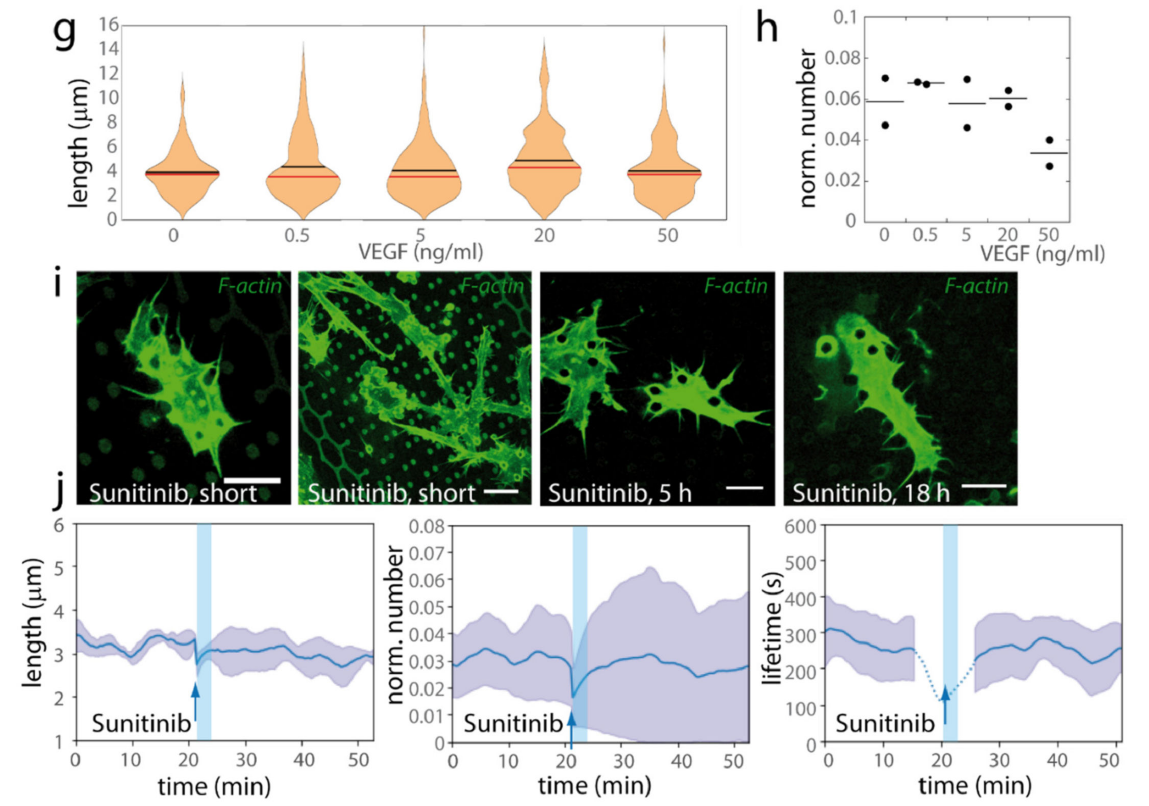
Figure 9. Dependence on VEGF. ( a – h ) HUVECs were cultivated on l7L14-open microstructures, and long- term cultures were performed in different VEGF concentrations. Cell organization was studied from fixed samples. ( a , b ) Culture without VEGF: ( a ) ECGM media (Promocell), which contains no VEGF supplement, ( b ) ECGM2 media without the VEGF supplement. ( b – e ) Standard ECGM2 media with ( c ) 0.5 ng/mL VEGF, ( d ) 5 ng/mL, ( e ) 20 ng/mL, and ( f ) 50 ng/mL. ( a – f ) Red, nuclei (and structure autofluorescence), green, F-actin. Bottom and top planes are represented. Cells fixed at time of structure colonization (2 ( b – f ) or 3 ( a ) days after cell seeding). Denoised images, bar 10 µ m. ( g , h ) Quantification for experiments realized in parallel in the different VEGF concentrations (2 days after cell seeding). The figure corresponds to an experiment where the five VEGF concentrations were analysed simultaneously, with two structures per condition. The generation of numerous filopodia for the conditions VEGF0 was observed in 3 additional independent microstructures (see raw data). ( g ) Histograms of filopodia lengths (black bar, mean value, red bar, median value). ( h ) Number of filopodia normalized by the perimeter on cell bodies in the bottom part of the structure. One point corresponds to one structure. ( i , j ) Effect of sunitinib (300 nM) treatment on HUVECs-Lifeact-GFP cells. Movies were acquired 1 day after cell seeding. ( i ) After sunitinib addition, cells still exhibited filopodia ( left ) and dactylopodia-like protrusions with filopodia ( middle-left ) (26 and 29 min after drug addition, respectively). Dynamic filopodia were still present after longer sunitinib treatments: 5 h ( middle-right ) or 18 h ( right ). Green, Lifeact-GFP, z projection of the bottom planes. Scale bars 10 µ m ( left , middle-right , right ), 15 µ m ( middle-left ). ( j ) Evolution along time of the mean filopodia length ( left ), of the number of filopodia normalized by the perimeter (in µ m) of the cell islets inside the structure ( middle ), and of the mean lifetime of filopodia present at this time, upon sunitinib treatment, n = 3 experiments per condition, errors: S.D. ( n = 3 independent experiments). Pre-treatment and post-treatment graphs are concatenated. The blue arrow indicates the time of drug addition. The light blue vertical bar indicates a state of stabilization of the system after media change (~3 min long). The dotted lines for lifetime ( c ) refer to times where the lifetime cannot be precisely assessed, because of the imaging interruption during media changes (durations, ~1 mean filopodia lifetime before and after drug addition; see Materials and Methods). No statistical difference was detected in filopodia dynamics upon sunitinib treatment (see Figure